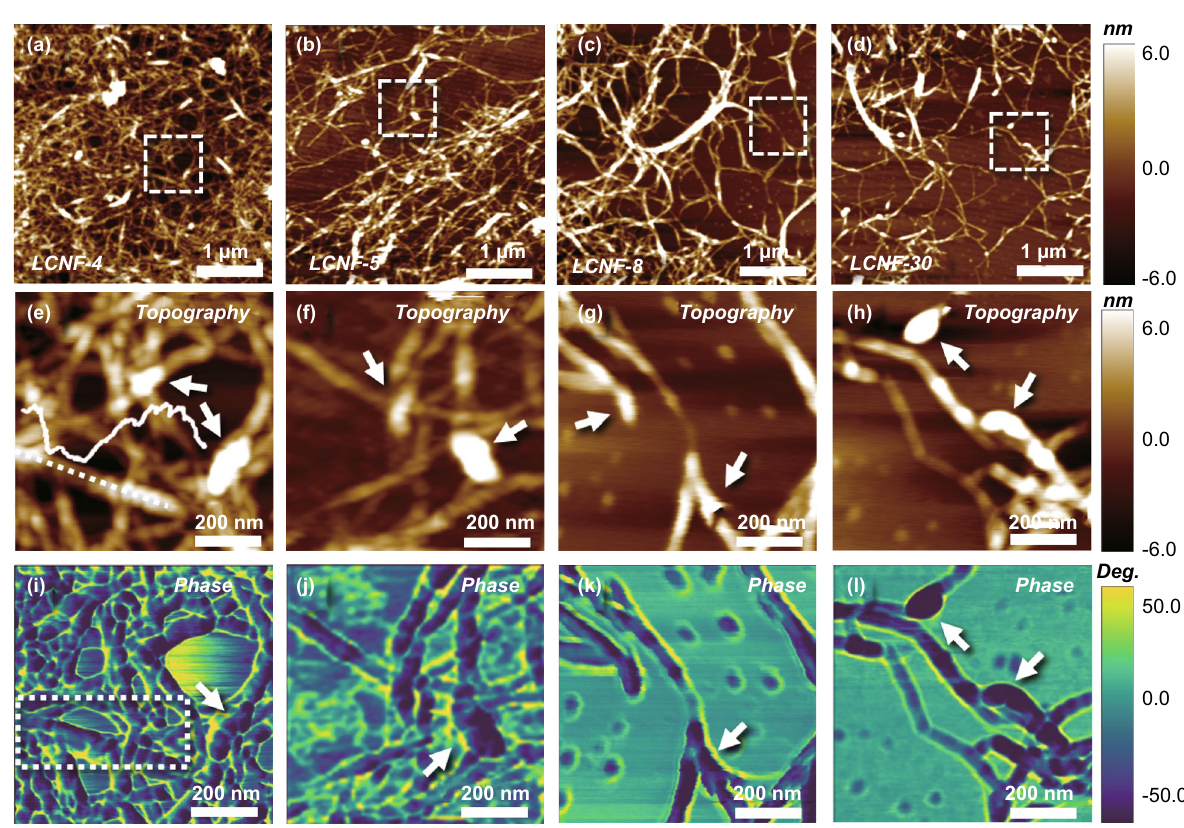
Fig. 1 AFM imaging of LCNF morphologies. a – d AFM topography images of LCNF-4, LCNF-5, LCNF-8, and LCNF-30. e – h High-resolution AFM topography images of the white dashed boxes in a – d . i – l Corresponding AFM phase images of e – h . The white arrows indicate the adhe- sive lignin on the surface of the